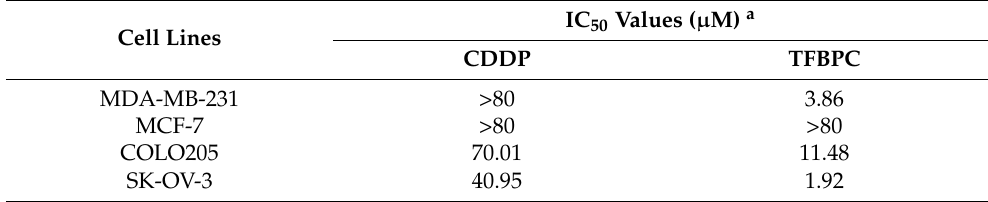
0.01; **** p < 0.0001. Table 2. IC 50 values of CDDP and TFBPC on breast cancer, colon cancer and ovarian cancer cell lines.